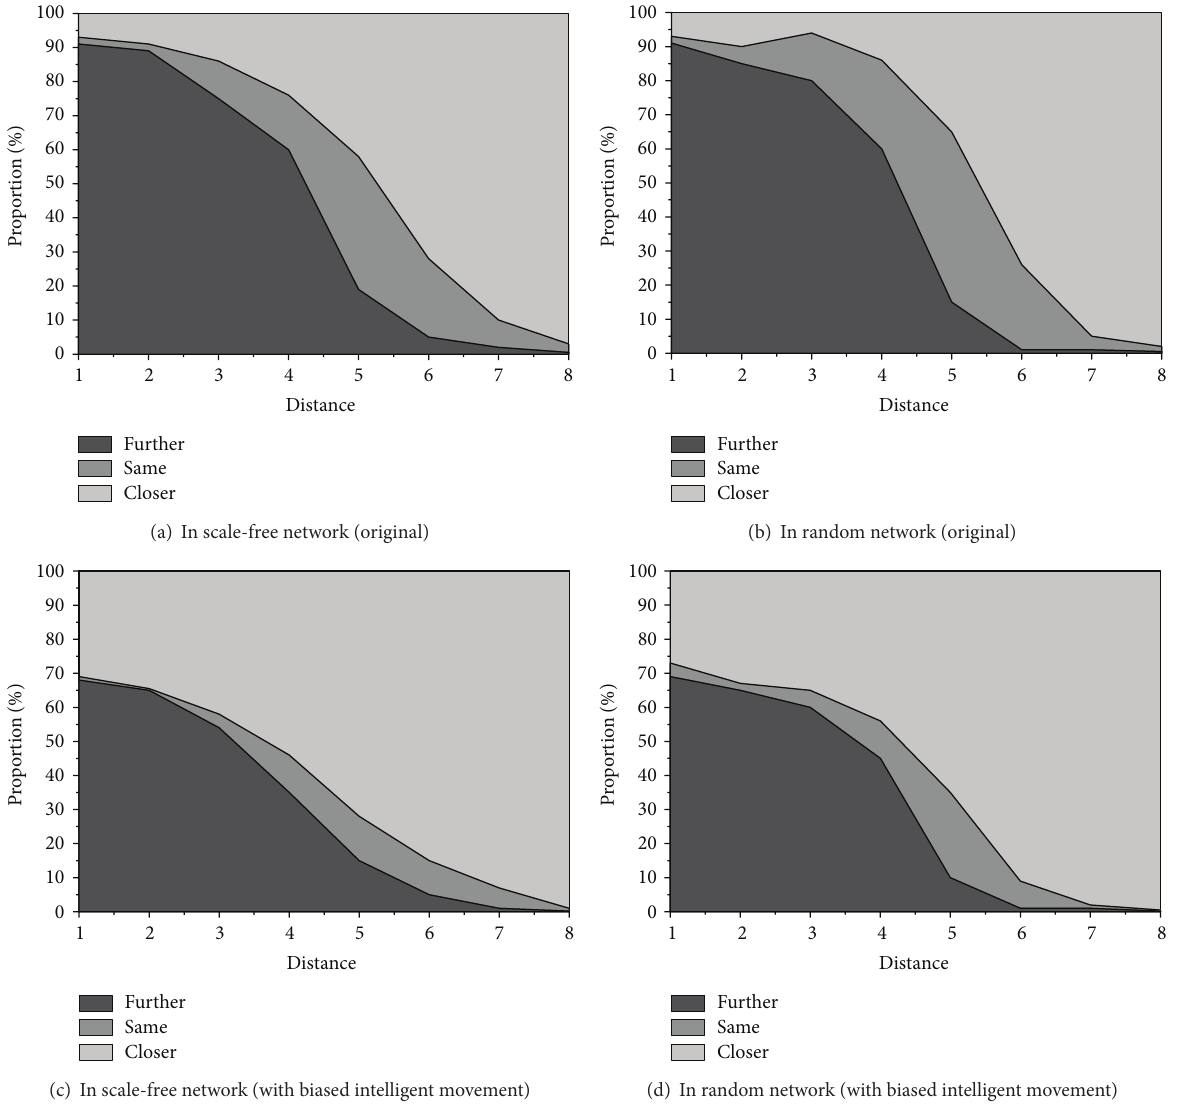
Figure 3: The relative proportions of links that lead closer to, keep the same distance, or move further from the target agent, as the distance to it is varied [10].